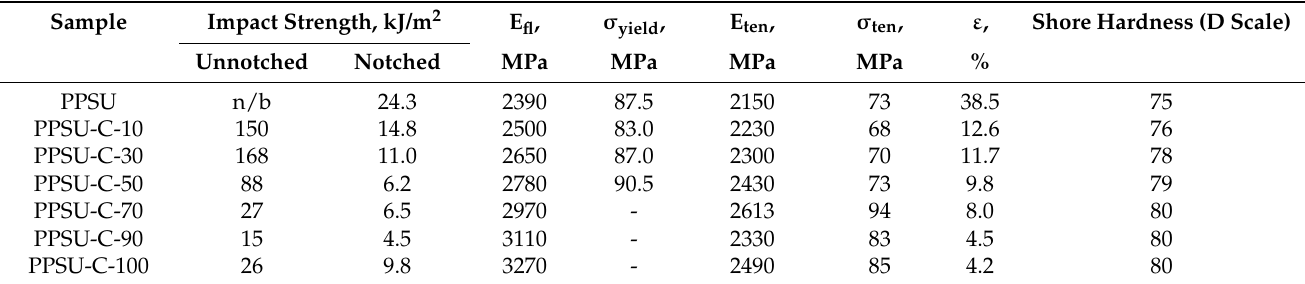
Figure 2. TGA curves: 1—PPSU; 2—PPSU-C-30; 3—PPSU-C-50; 4—PPSU-C-70; 5—PPSU-C-100. Table 3. Mechanical properties of PPSU and